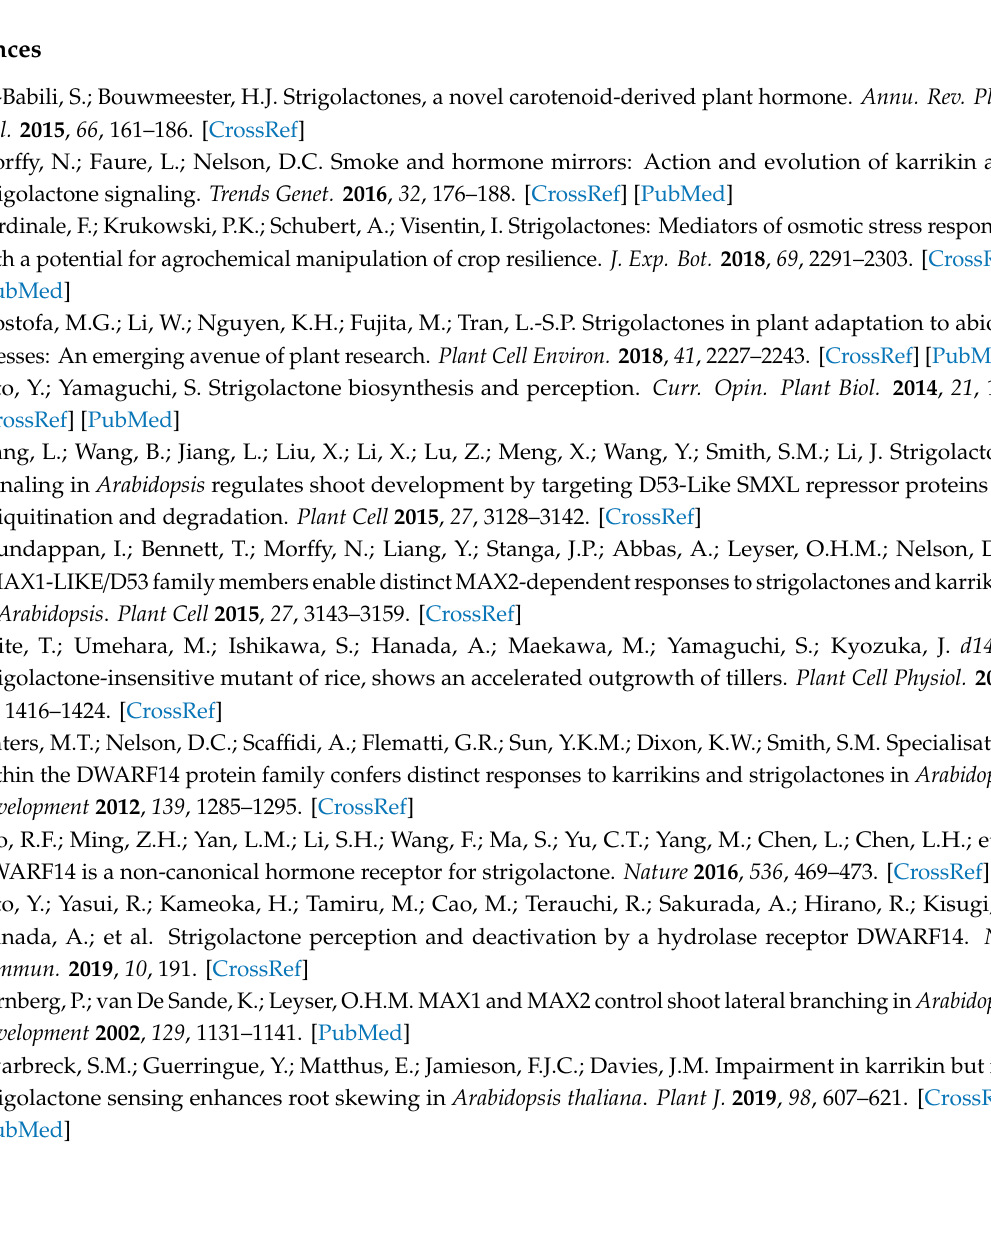
Figure S1. Drought-resistant phenotypes of various smxl single, double and triple mutant plants, Figure S2. Expression of SMXL6, 7 and 8 genes in wild-type plants under normal and dehydration conditions, Table S1: Primers used for